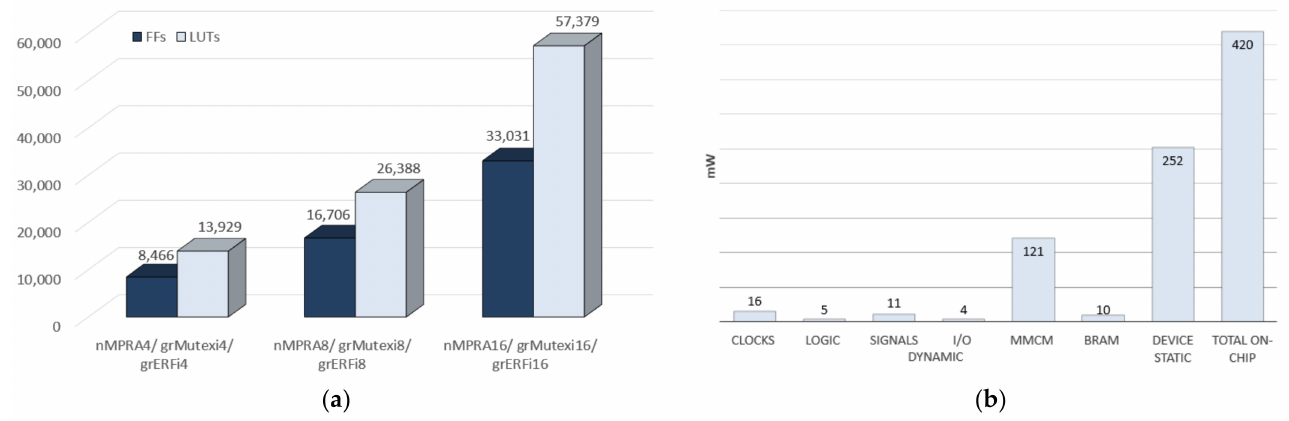
Figure 7. ( a ) FPGA resource requirements in terms of different HW_RTOS_nMPRA configurations; ( b ) power consumed by the HW_RTOS_nMPRA implementation, including support for the dynamic